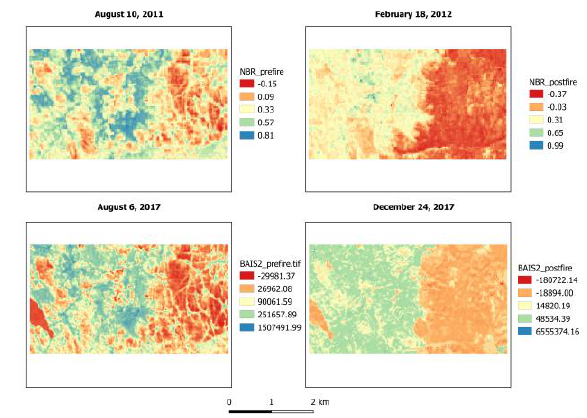
Figure 2. NBR and BAIS2 indexes pre-fire and